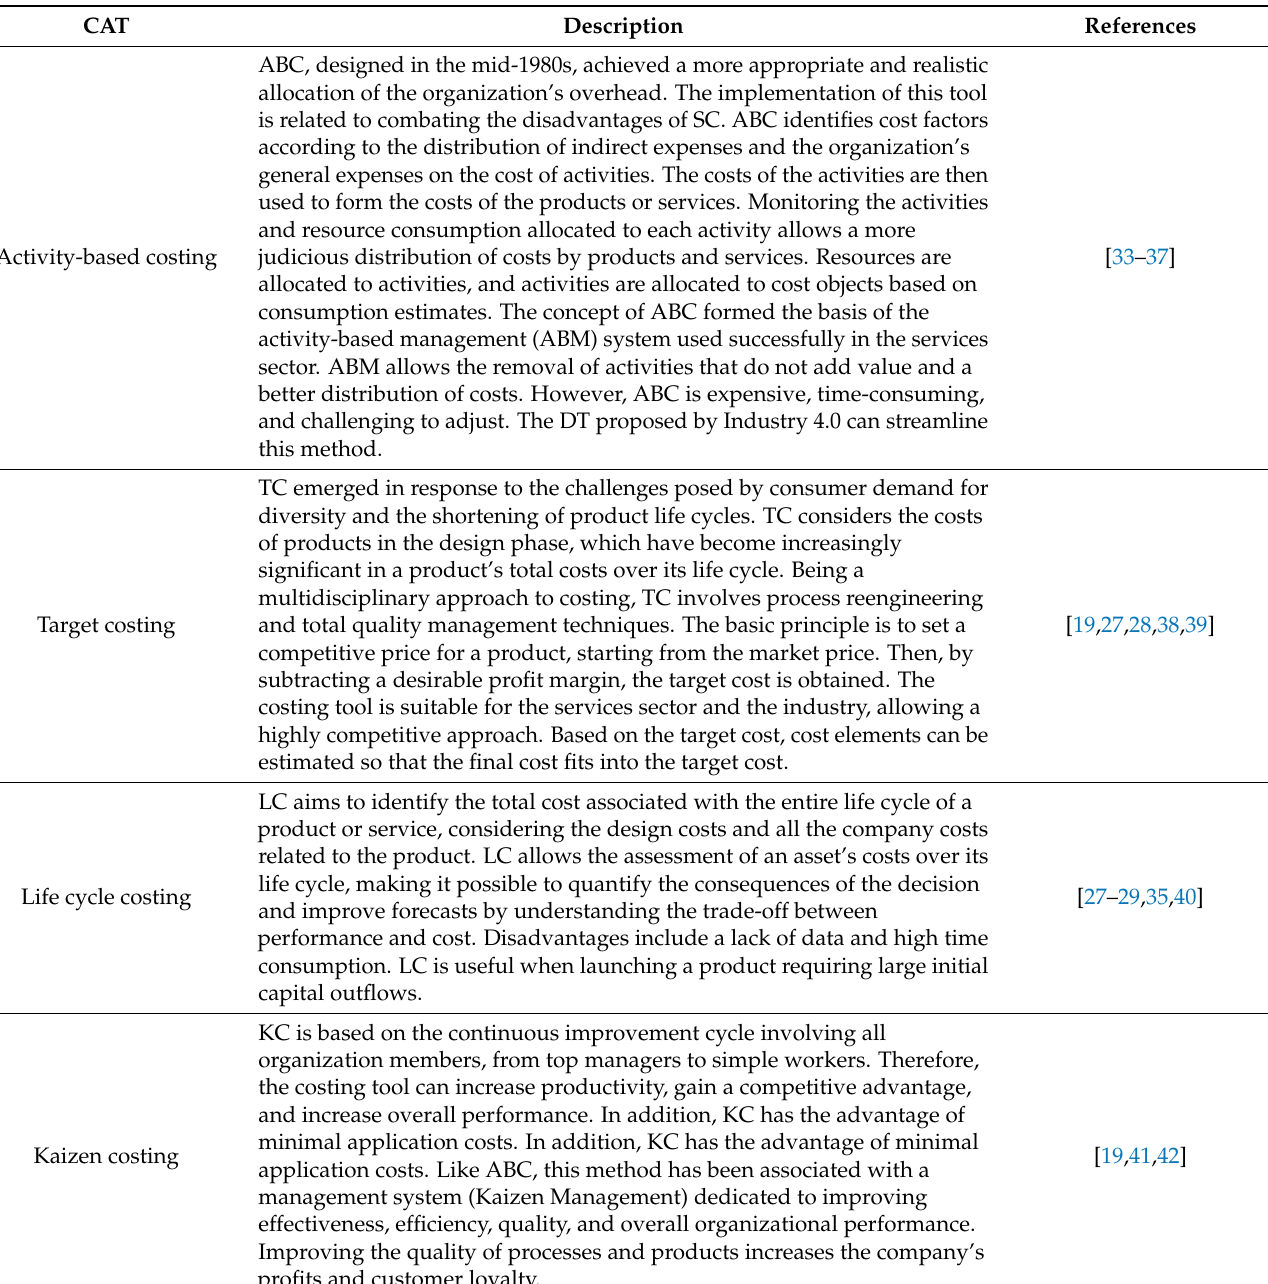
Table 2. Innovative cost accounting